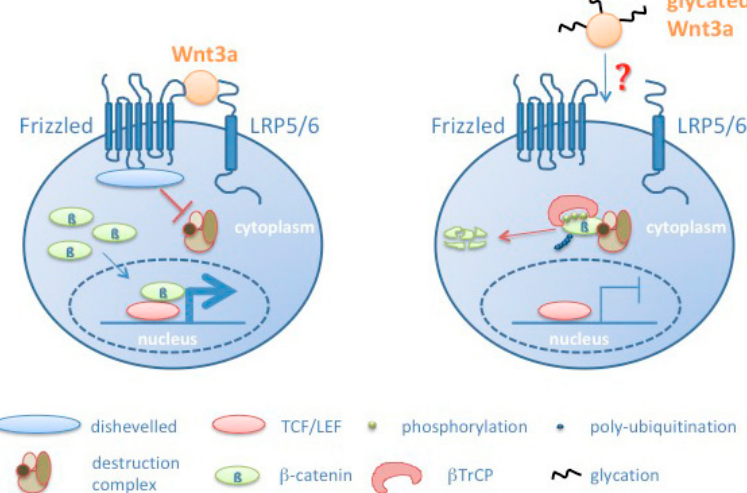
Figure 8. Schematic model summarizing effects induced by Wnt glycation, resulting in increased phosphorylation of β -catenin, its subsequent degradation and reduced transcription of Wnt target genes. β TRCP: β -transducin repeat containing protein.